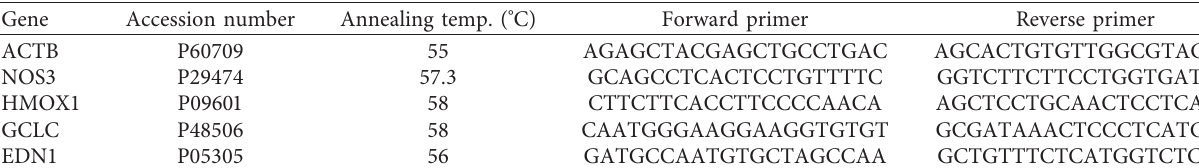
Table 1: Primer sequences of target genes for real-time PCR.